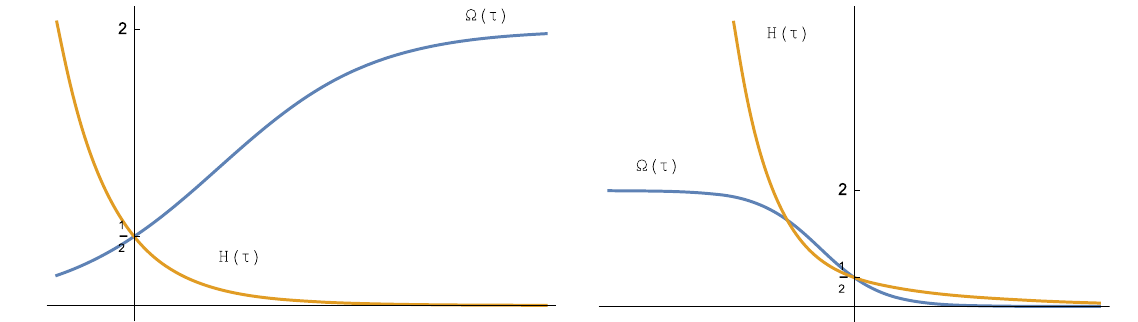
Fig. 2 Solutions for γ = − 2 / 3 and γ = 1 / 2. In the first case the solution (4.2) increases following the usual logistic curve and quickly approaches the constant value 2